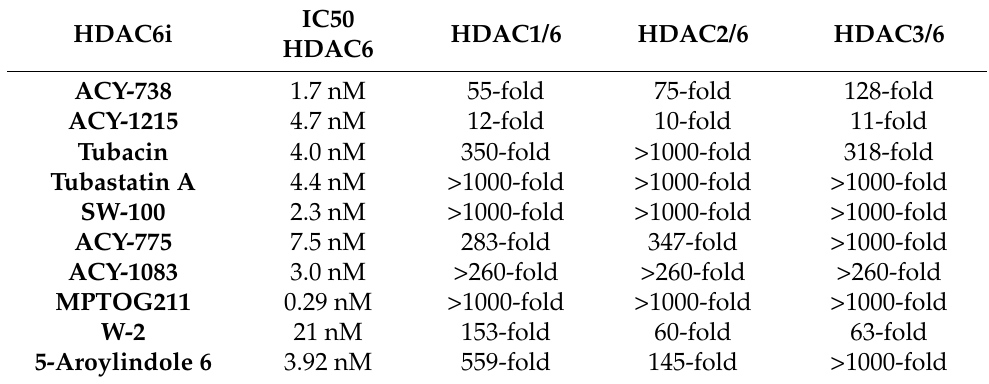
Table 1. HDAC6 inhibitors and selectivity over HDAC 1, 2, and 3. The half maximal inhibitory concentration (IC50) is indicated for each HDAC6 inhibitor. The selectivity over HDAC 1, 2, and 3 is indicated for each drug. The selectivity index is the ratio of each HDAC IC50 vs. HDAC6